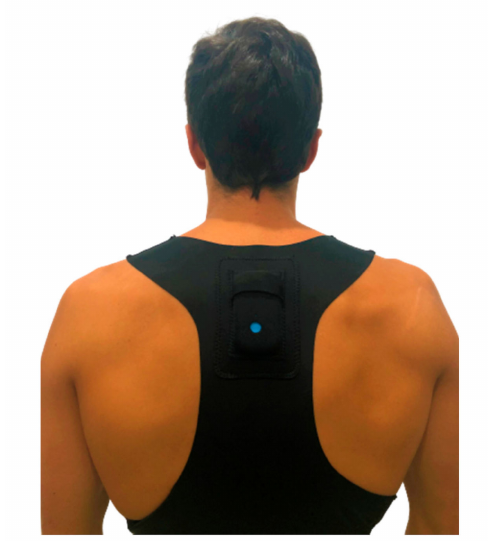
Figure 1. Tracking system placed in the back pocket of a chest